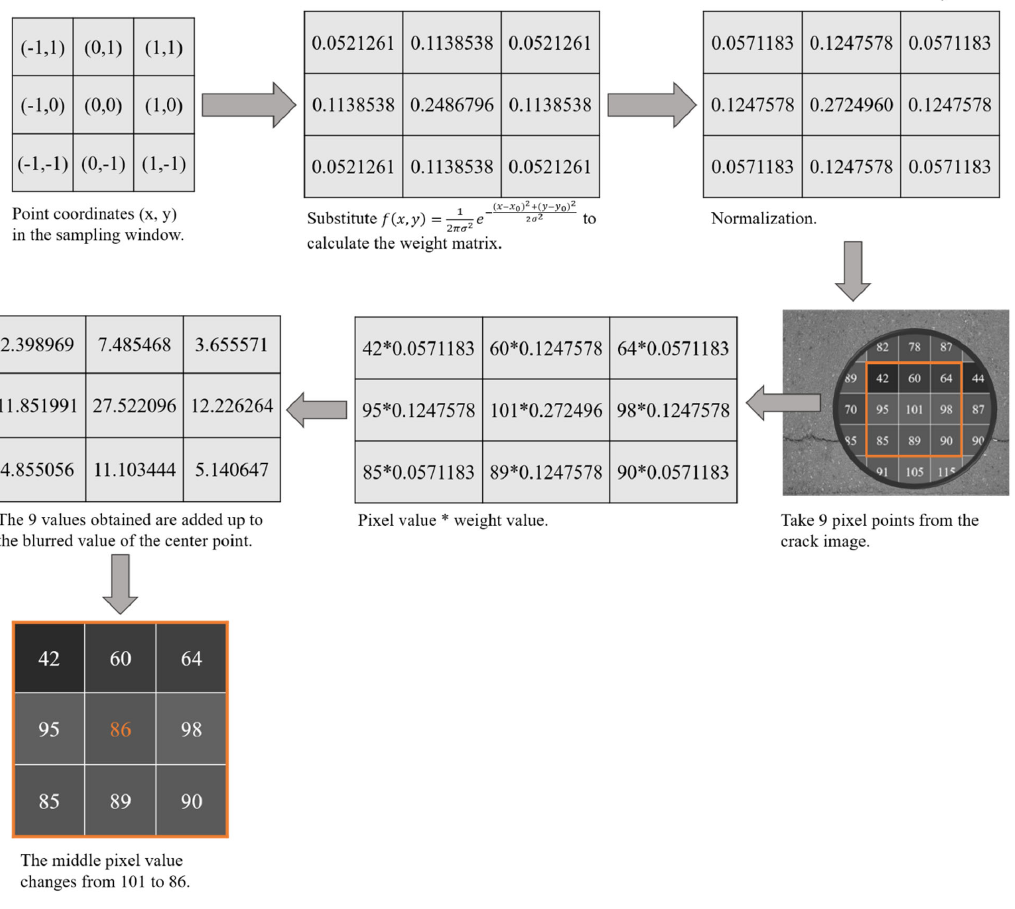
Figure 2. Pipeline of the 1st algorithm. Take the sampling window is 3 × 3, 𝜎 (cid:3051) , 𝜎 (cid:3052) = 0.8, and the center point (cid:4666)𝑥 (cid:2868) , 𝑦 (cid:2868) (cid:4667) is (0, 0) as an example. center point ( x 0 , y 0 ) is (0, 0) as an